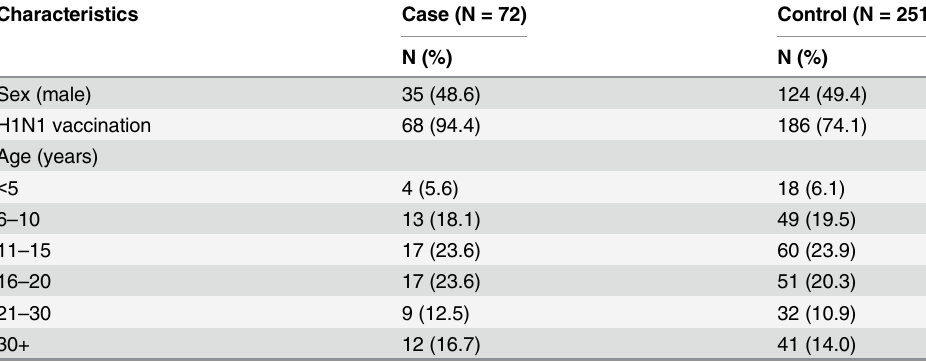
Table 1. Characteristics of the study